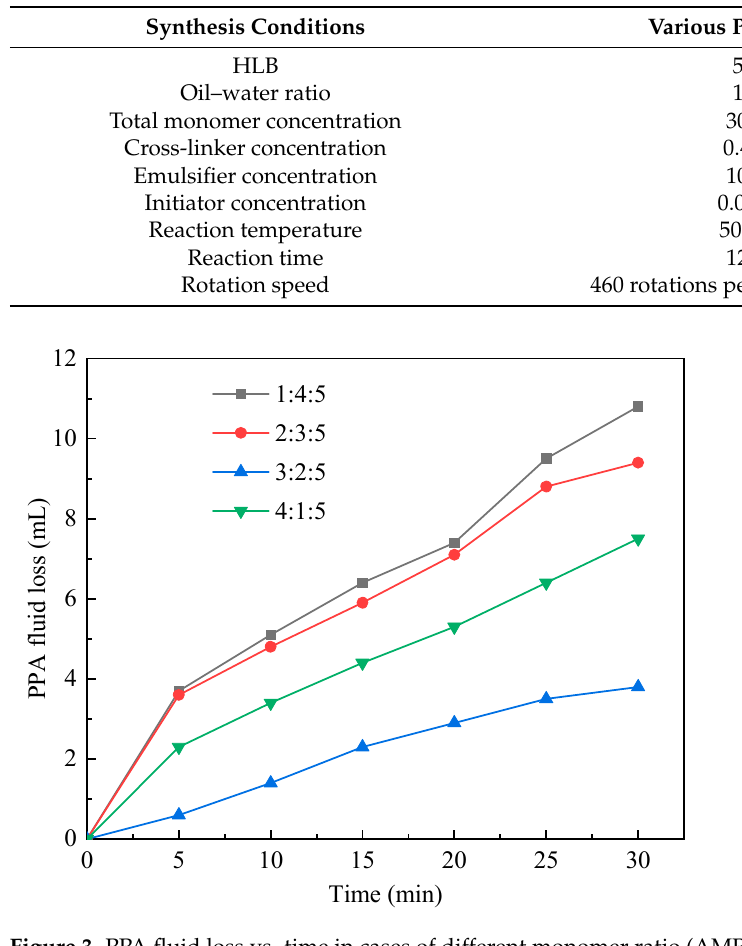
Figure 3. PPA fluid loss vs. time in cases of different monomer ratio (AMPS:AM:NVP).